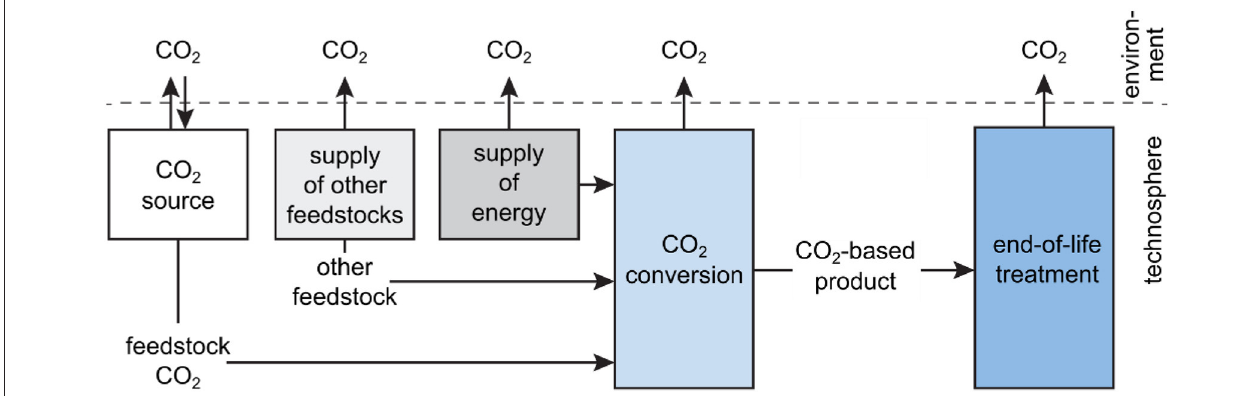
FIGURE 6 | Schematic life cycle of CCU technologies span from the CO 2 source, supply other feedstocks and energy to the end of life treatment. In all life cycle stages, environmental impacts should be considered. Adopted from von der Assen et al.